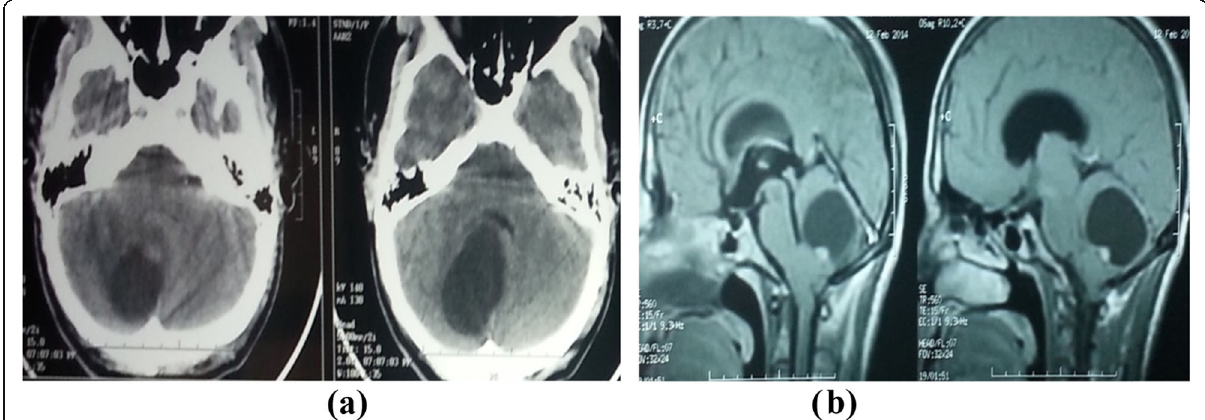
Fig. 1 a , b Preoperative radiological brain images with contrast for 23-year-old male of posterior fossa space occupying lesion (cystic mass with mural enhanced nodule): a CT axial cuts and b T1-weighted MRI sagittal